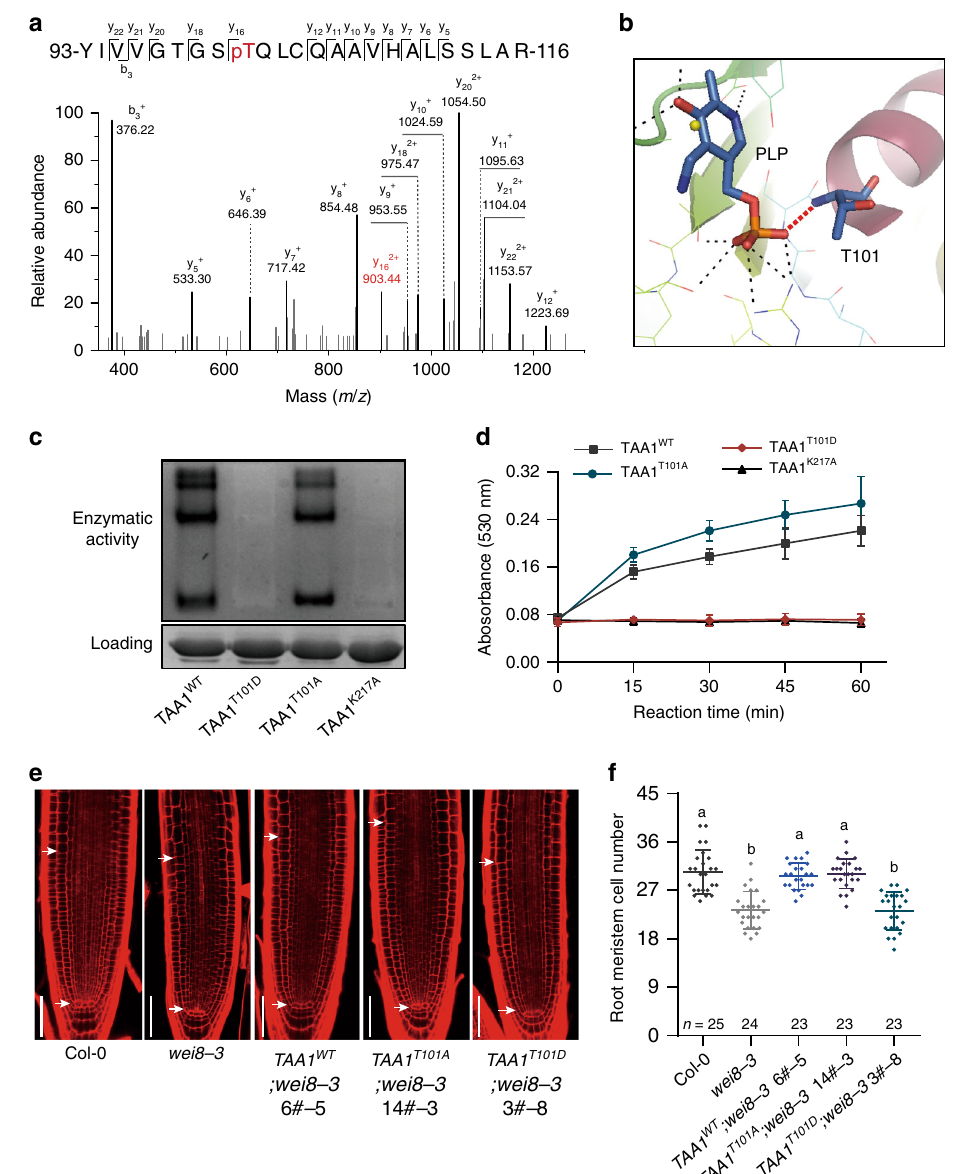
Fig. 1 Phosphorylation modi fi cation on T101 residue turns off TAA1 enzymatic activity. a Mass spectrometric analysis showing the phosphorylation modi fi cation at Thr101 site on TAA1. b Structural simulation of the connection between T101 residue and PLP cofactor. c In gel tryptophan aminotransferase activity (Trp-AT) of E. coli -puri fi ed GST-TAA1 WT , GST-TAA1 T101A , and GST-TAA1 T101D . GST-TAA1 K217A was set as a control. Protein amount shown using Coomassie blue staining. E. coli -puri fi ed proteins were separated in a native gel followed by the catalytic reaction and further staining. The intensity of dyed bands in the gel represent catalytic activity. Lack of a dark band in the GST-TAA1 T101D and GST-TAA1 K217A lanes indicate complete loss of enzymatic activity. Three independent biological repeats showed similar results. d Transaminase catalytic activity detected by measuring IPA production with Salkowski reagent (Methods section). Transaminase catalytic reactions were performed in the reaction reagent containing 2.5 μ g recombinant protein with a His tag. The products were measured by reading the absorbance at 530 nm at different reaction time points. Values denoted the mean ± s.d. ( n = three independent biological repeats). e Representative pictures of root apical meristem from 5-day-old seedlings in Col-0, wei8-3 , and pTAA1-gTAA1 (WT, T101D, T101A) ; wei8-3 complementation transgenic plants. White arrows show the meristem zone; Scale bar 50 μ m. f Quanti fi cation of root meristem size in e . Three independent lines of TAA1 WT ;wei8-3 and TAA1 T101D ;wei8-3 , and 2/7 lines of TAA1 T101A ;wei8-3 showed similar results. n denotes the number of independent seedlings; one-way ANOVA with Tukey multiple comparisons test. Different letters represent signi fi cant difference between each other, P <